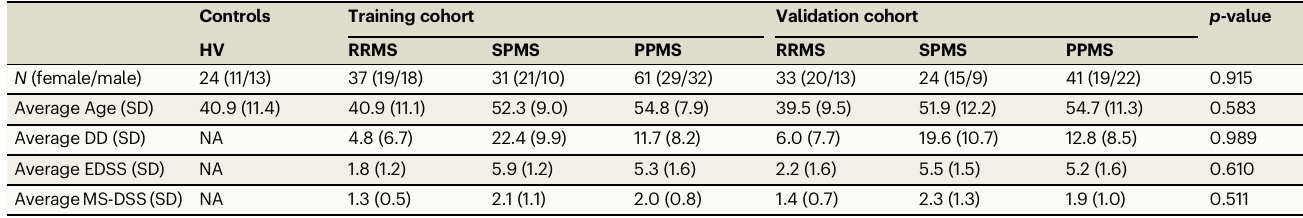
Table 1 | Demographic data for the training, validation, and HV cohorts